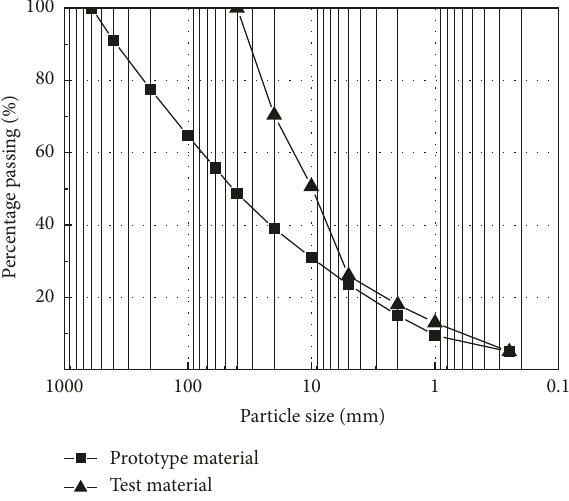
Figure 2: Grain-size distribution curve of test